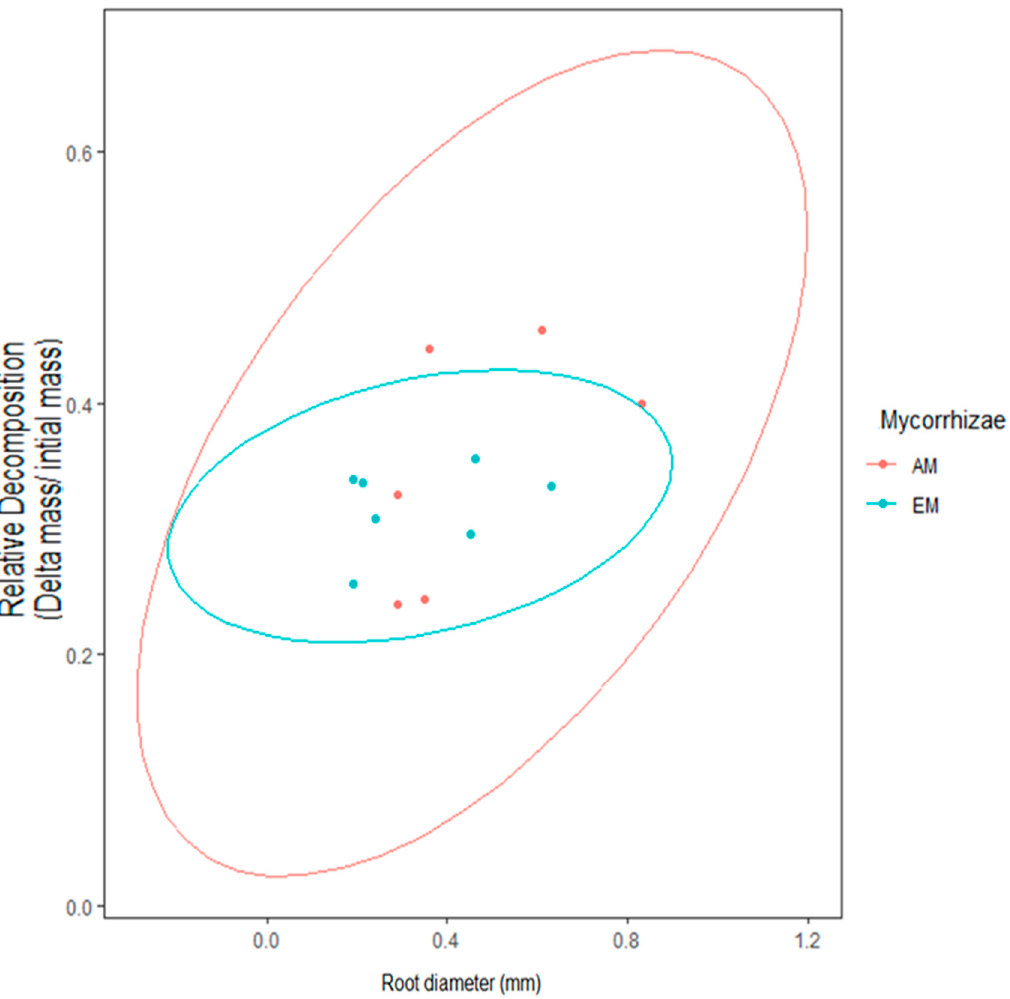
Figure A5. Observed here are 95% CI ellipses in the context of mycorrhizal type. AM root zones had a broader range in decomposition outcomes in comparison to EM root zones.